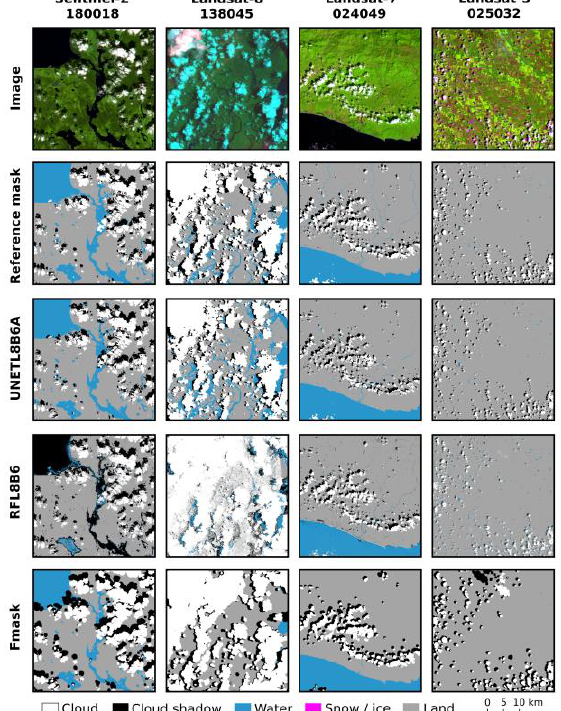
Figure 3. Selected results for the best performing U-Net and Random Forest models as well as Fmask.